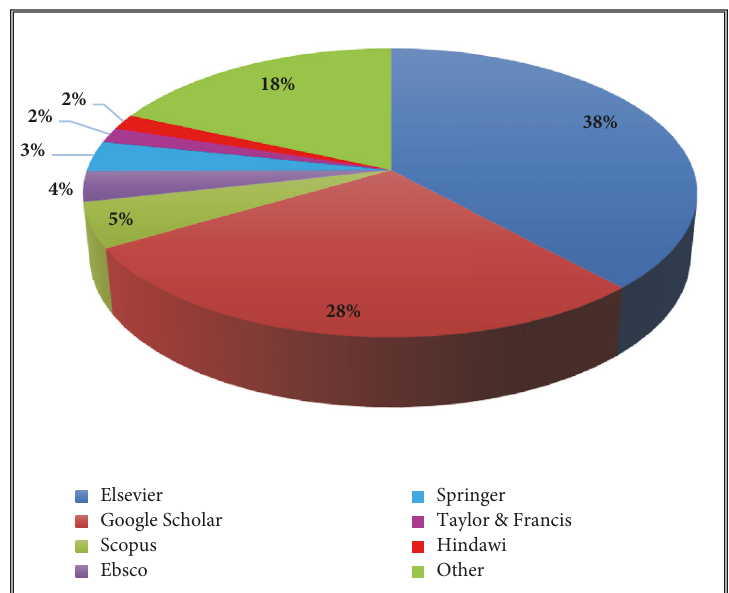
Figure 1: Databases from which literature was retrieved for the